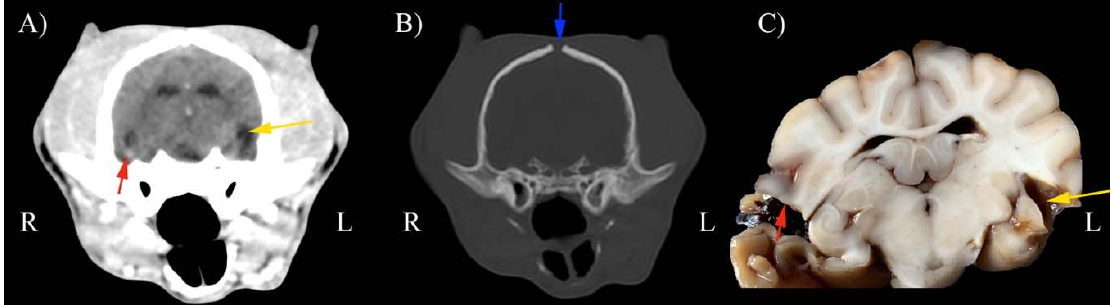
Figure 4. Representative post-contrast CT scans of the same position in a red fox with soft tissue reconstruction kernel and WW (100) WL (50) for the brain ( A ). Bone reconstruction kernel and WW (1500) WL (300) for bone tissue ( B ). ( C ) Gross anatomic section. Note severe hypodense area and related atrophic cerebral area at the level of proliferative left temporal fracture repair (yellow arrows). Hyperdense area (red arrows) corresponding to chronic hemorrhage. Blue arrow represents persistent fontanelle. Right ( R ) on the left of the image, left ( L ) on the right of the image.